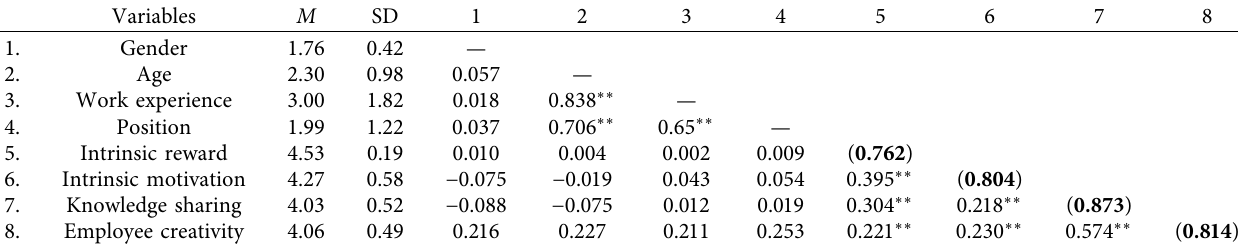
Table 3: Descriptive statistics of the study